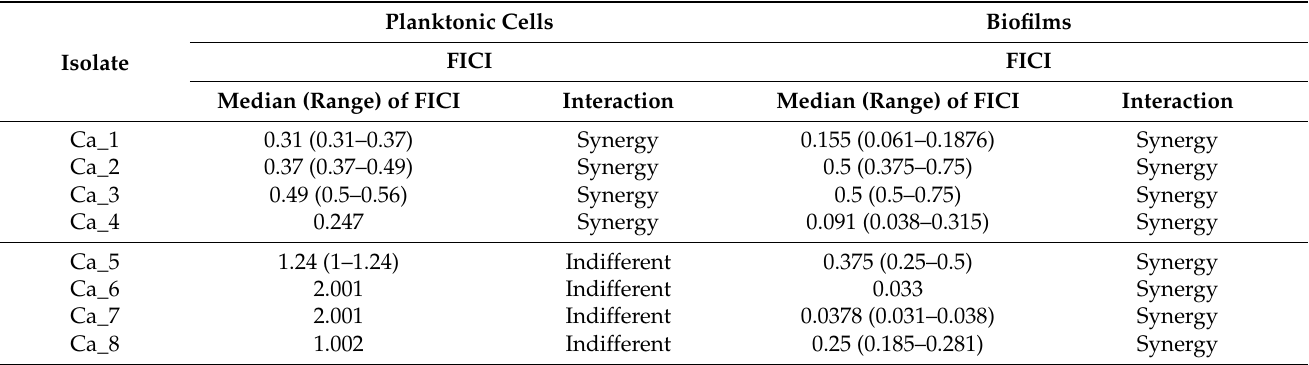
Table 3. In vitro interactions by FIC indices (FICI) of caspofungin in combination with posaconazole against Candida auris planktonic cells and biofilms.